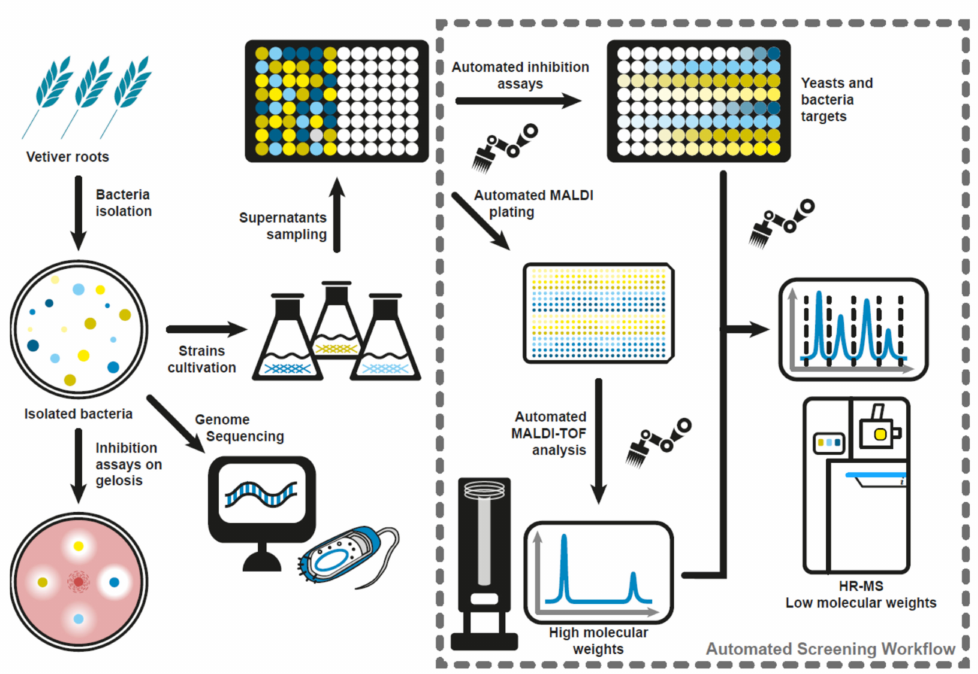
Figure 1. Diagram showing the screening workflow used in this work. This is composed of a first step of screening of antifungal activities on Petri dish and a second robotized step of high-throughput screening of antimicrobial activities and identification of secondary lipopeptide metabolites by high-resolution mass